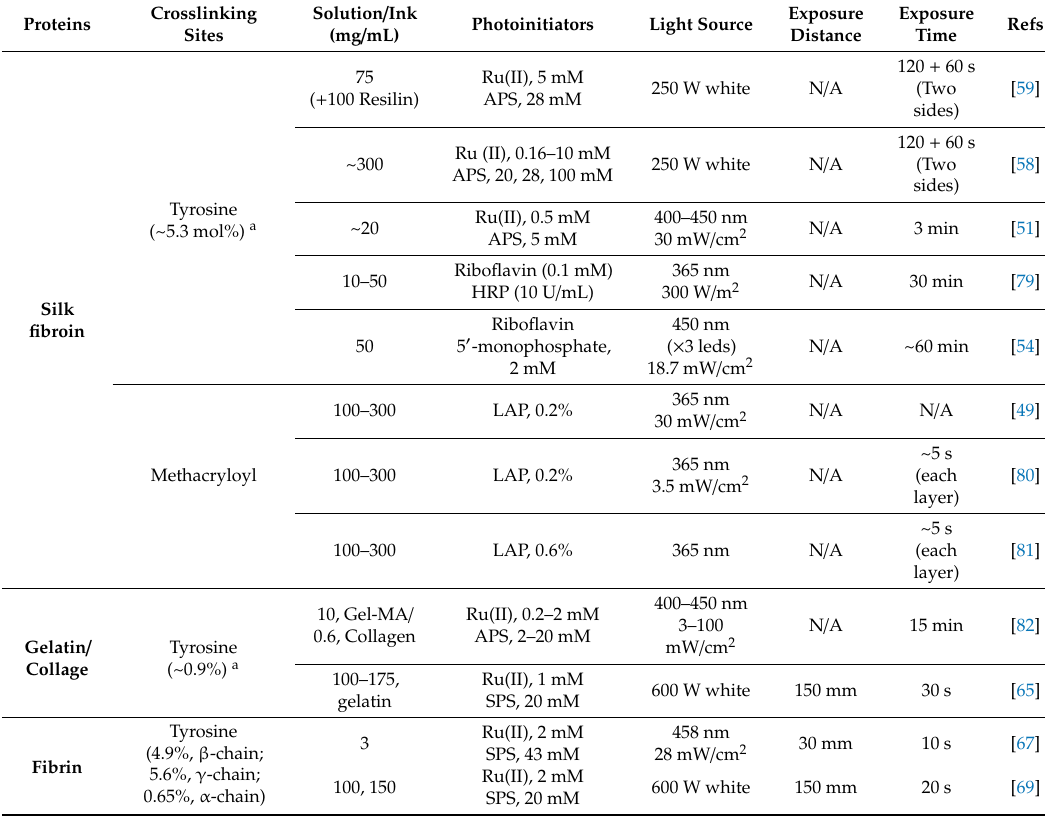
Table 1. Summary of photo-crosslinking conditions of silk fibroin and other